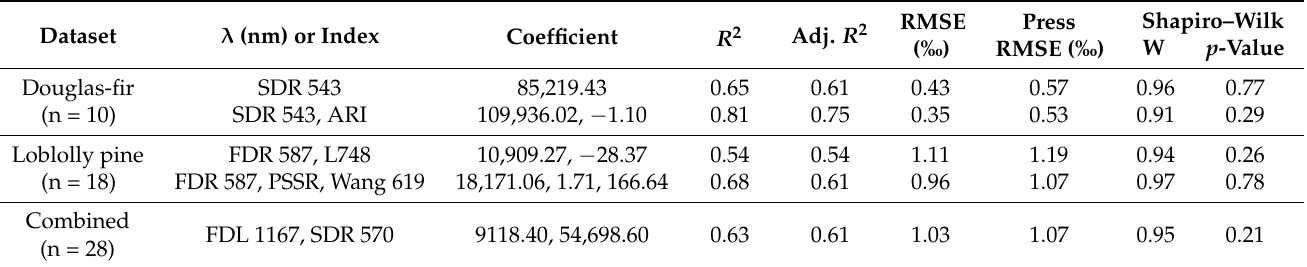
Table 4. Multiple linear regression models selected by a best subsets approach using leaf-level spectroscopy data to predict foliar δ 15 N (‰) in Douglas-fir, loblolly pine, and a combined data set of both species. R = reflectance, FDR = 1st derivative of R, SDR = 2nd derivative of R, L = log of 1/R, FDL = 1st derivative of the log of